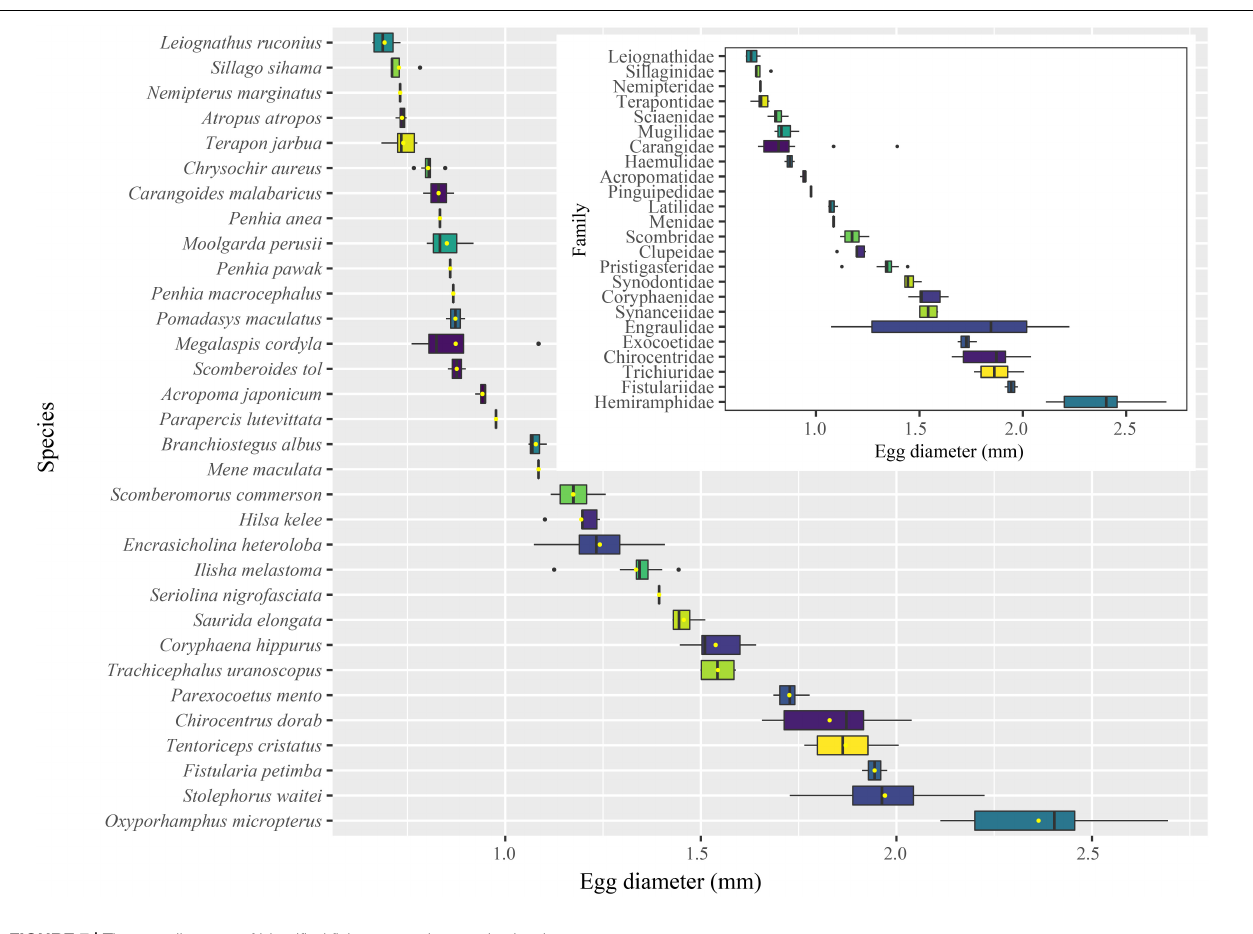
FIGURE 7 | The egg diameter of identified fish eggs at the species